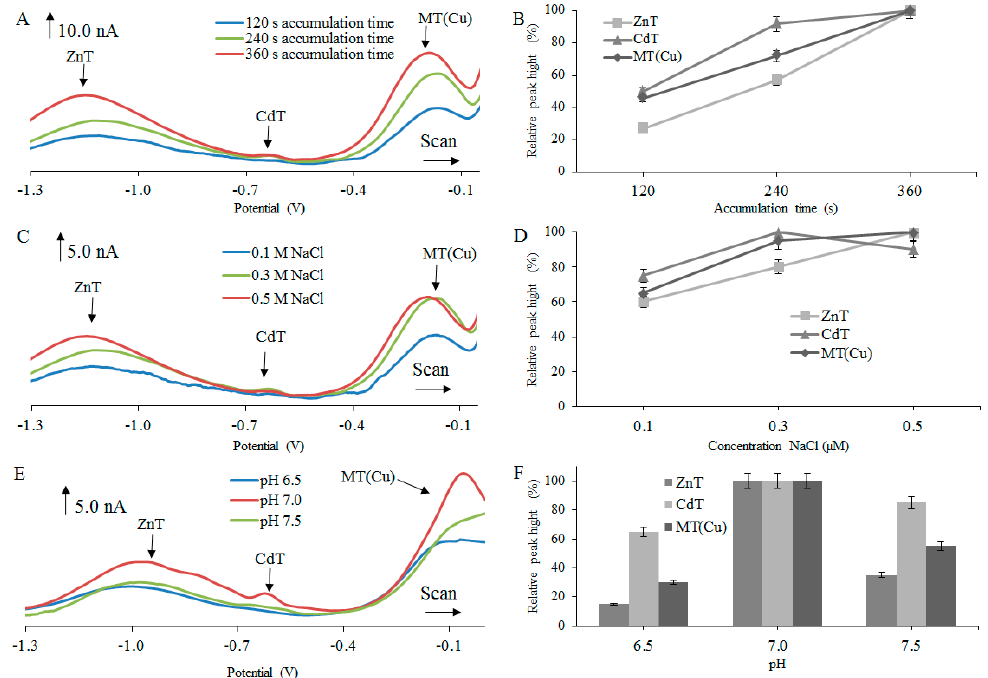
Figure 1. Differential pulse (DP) voltammograms of 2 µM rabbit MT2 protein (rMT2) measured in different ( A ) accumulation times, ( C ) concentration of NaCl, and ( E ) pH. Adsorptive transfer stripping technique coupled with differential pulse voltammetry (AdTS DPV) parameters were as follows: initial potential − 1.5 V, end potential 0.0 V, modulation time 0.057 s, time interval 0.2 s, step potential of 1.05 mV/s, and modulation amplitude of 25 mV. Dependences of heights of ZnT, CdT, and MT(Cu) signals on ( B ) accumulation times of 120 , 240 , 360 s; ( D ) concentration of electrolyte (0.1, 0.3, 0.5 M); and ( F ) pH (6.5, 7.0, 7.5), expressed in relative percentage peaks and peak height (nA).